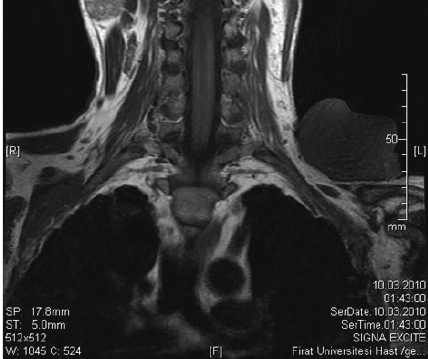
Figure 2: MR image of the mass.